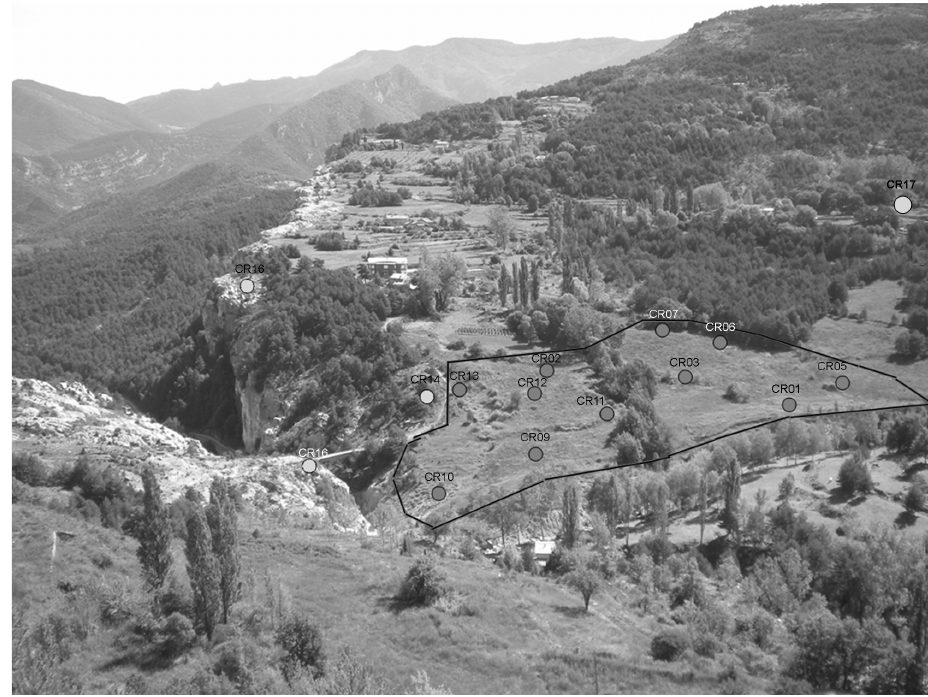
Fig. 5. Location of the GB-SAR CRs and the used extensometers on the Vallcebre test site. The white dots indicate the CRs located in stable areas, while the grey dots are the CRs deployed on the sliding area (black line bounded). Eastwards view from the GB-SAR base station.